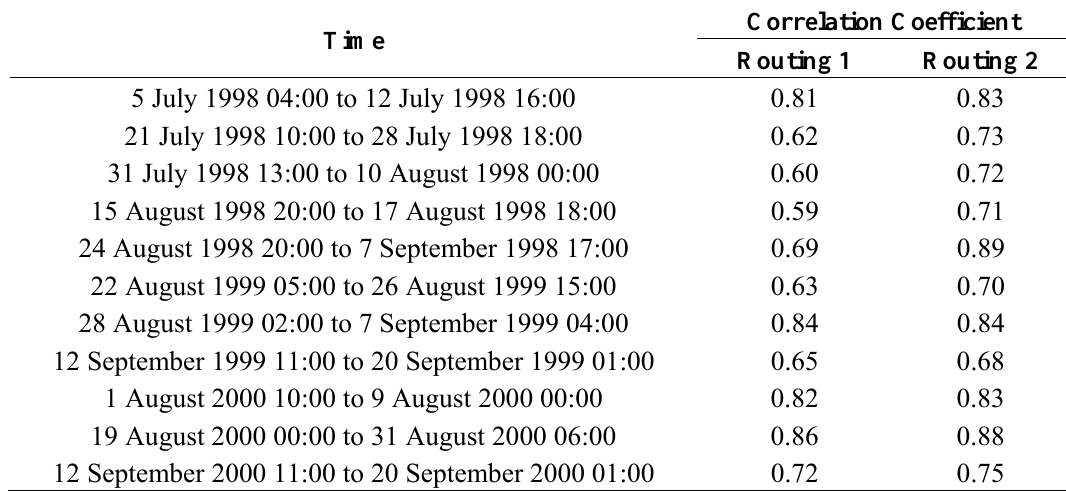
Figure 2. Observed and simulated hourly stream flow and base flow at Lhasa in 1998. Table 5. Correlation coefficients for flood events occurred at Lhasa station from 1998 to